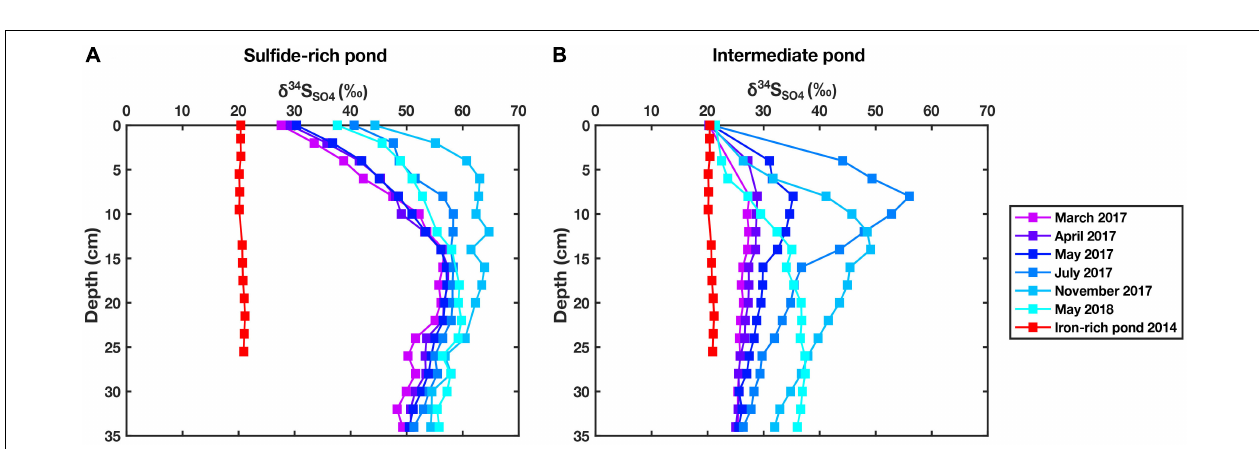
FIGURE 5 | Core horizontally extracted from creek wall (see Figure 1 for location). Depth is 20 cm from the surface of the salt marsh. (A) Fe(II) concentrations (mM) (B) Cl concentrations (M) (C) δ 34 S SO4 (D) [SO 4 ]/[Cl]. Blue dashed line corresponds with seawater values. Location shown in Figure 1 .